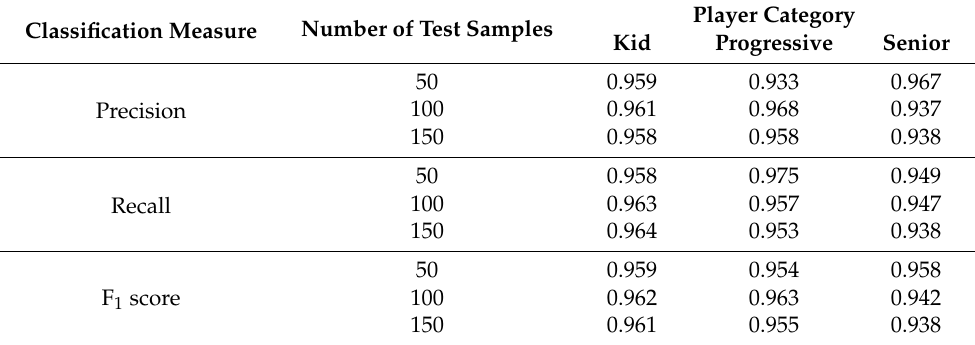
Table 4. Player classification results for the NN 1 (trained with 150 samples).